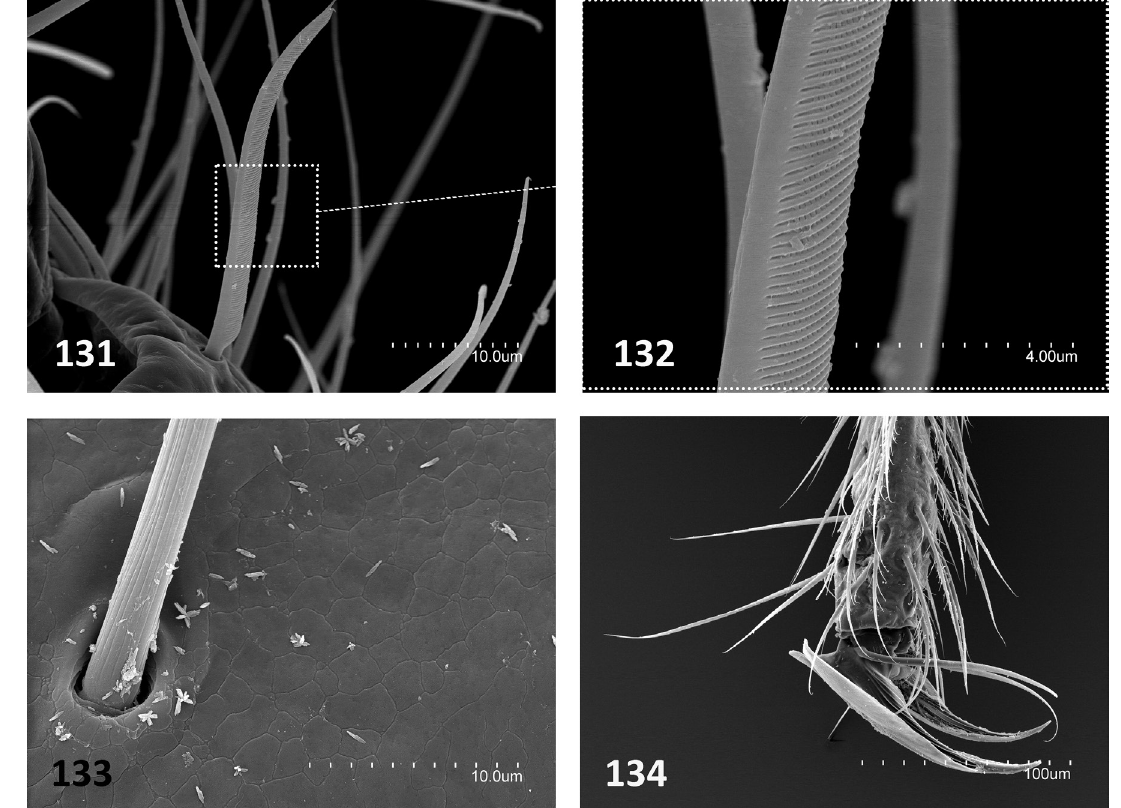
Figs 131–134. Plusiocampa ( Plusiocampa ) schweitzeri Condé, 1947, from Govještica, Banja stijena, Rogatica, Bosnia and Herzegovina (Coll. AS). 131 . Medial antennomere, latero-distal view. 132 . Medial portion of a gouge sensillum, detail. 133 . Surface of metanotum, detail. 134 . Distal portion of tarsus and pretarsus, lateral